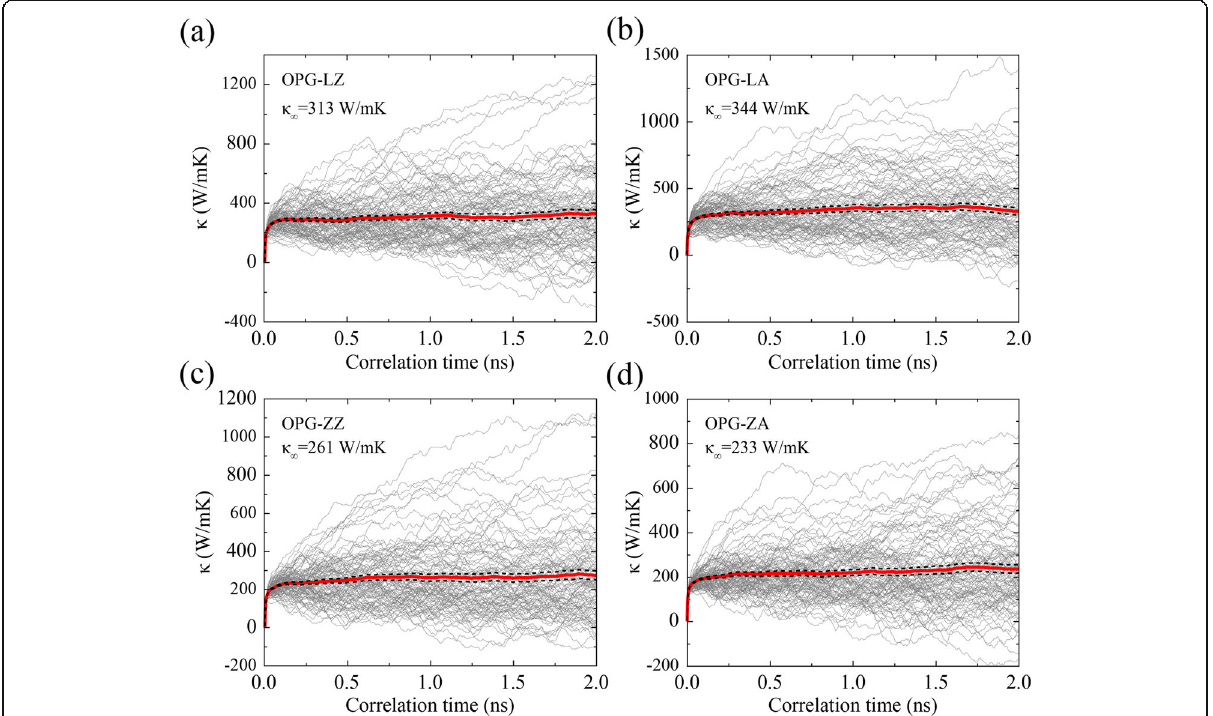
Fig. 5 Evolution of TC of a OPG-LZ, b OPG-LA, c OPG-ZZ, and d OPG-ZA at 300 K as a function of correlation time. The thin lines represent the results from 100 independent simulations and thick solid and dashed lines represent their average and error bounds. κ ∞ is the TC of an infinite sample, which is obtained by averaging the running TC in correlation time from 1.0 to 2.0 ns